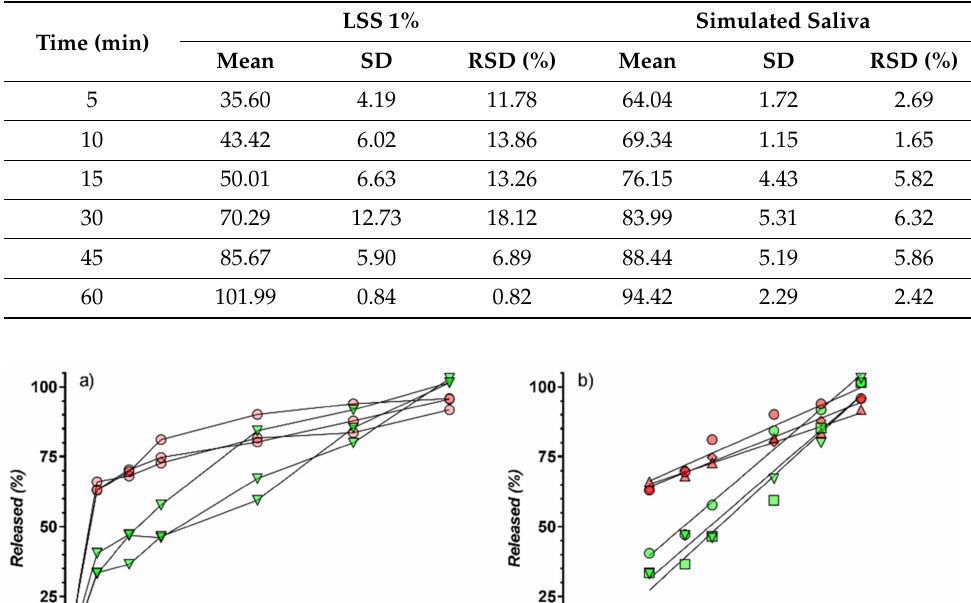
Table 1. The individual and mean values of release in LSS and SS.